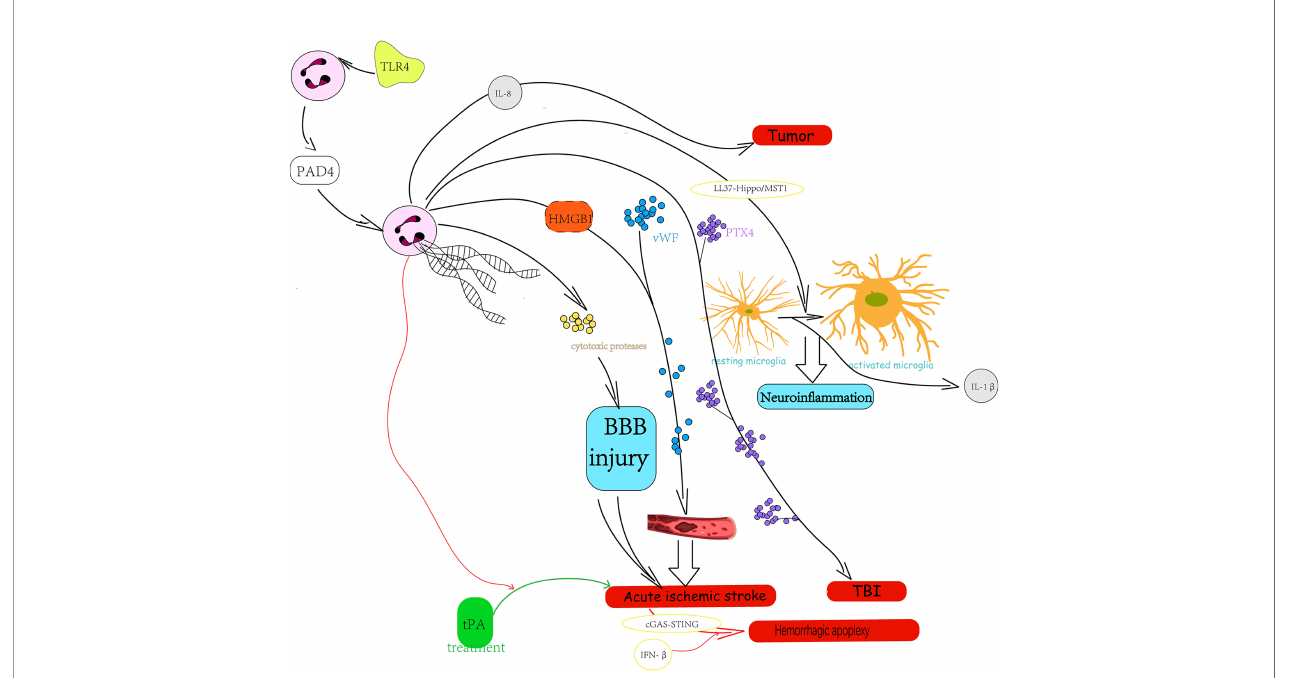
FIGURE 2 | The role and possible mechanism of neutrophil extracellular traps in central nervous system